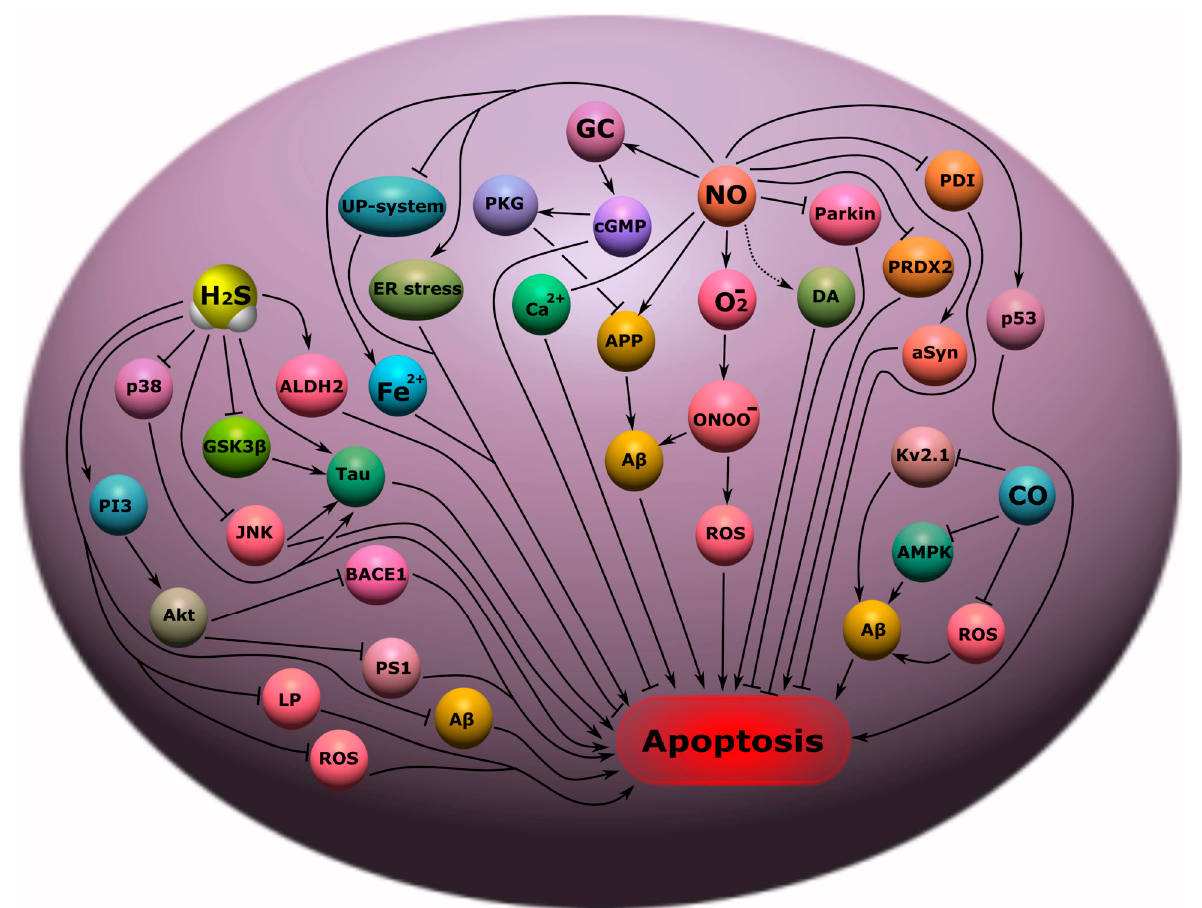
Figure 9. Possible gasotransmitter-dependent signaling mechanisms regulating apoptosis in neurodegenerative diseases. NO, nitric oxide; CO, carbon monoxide; H 2 S, hydrogen sulfide; ROS, reactive oxygen species; O 2 − , superoxide anion radical; ONOO − , peroxynitrite; GC, guanylyl cyclase; cGMP, cyclic guanosine monophosphate; PKG, protein kinase G; Ca 2+ , calcium ions; APP, amyloid-beta precursor protein; A β , amyloid beta; UP-system, ubiquitin-proteasome system; ER stress, endoplas- mic reticulum stress; Fe 2+ , iron ion; p38, p38 mitogen-activated protein kinases; GSK3 β , glycogen synthase kinase-3 beta; ALDH2, aldehyde dehydrogenase 2; PI3, phosphorus triiodide; Akt, protein kinase B; LP, lipid peroxidation; JNK, c-Jun N-terminal kinases; Tau, microtubule-associated protein tau; BACE1, beta-site APP cleaving enzyme-1; PS1, presenilin-1; Parkin, E3 ubiquitin ligase; DA, dopamine; PDI, protein disulfide-isomerase; PRDX2, peroxiredoxin 2; aSyn, alpha-synuclein; Kv2.1, voltage-gated potassium channel KV 2.1; AMPK, AMP activated protein kinase. Arrows with a sharp end—positive regulation; arrows with a blunt end—negative